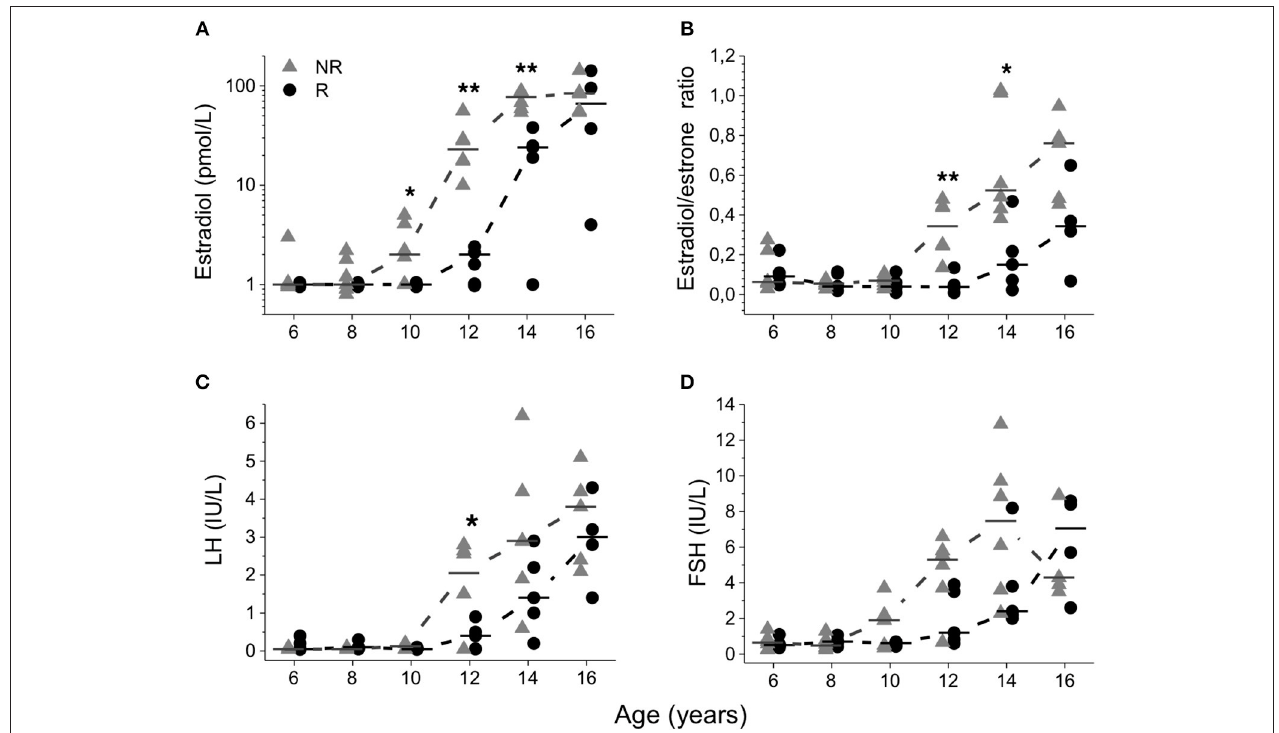
FIGURE 3 | Serum estradiol concentrations (A) , estradiol/estrone ratio (B) , luteinizing hormone (LH) (C) , and follicle stimulating hormone (FSH) (D) plotted relative to age. Median values were calculated and denoted as a line for each group and age. Triangles represent non-responders (NR) and circles represent responders (R). Differences between groups are shown as * p < 0.05 and ** p <